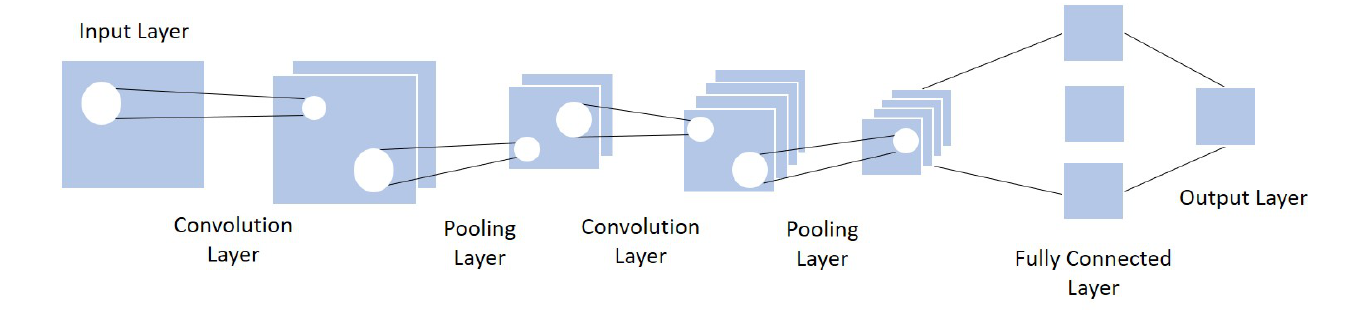
Figure 3. Usual CNN architecture (adapted from [56]). Table 2 details each usual CNN layer with its actions, parameters, inputs and